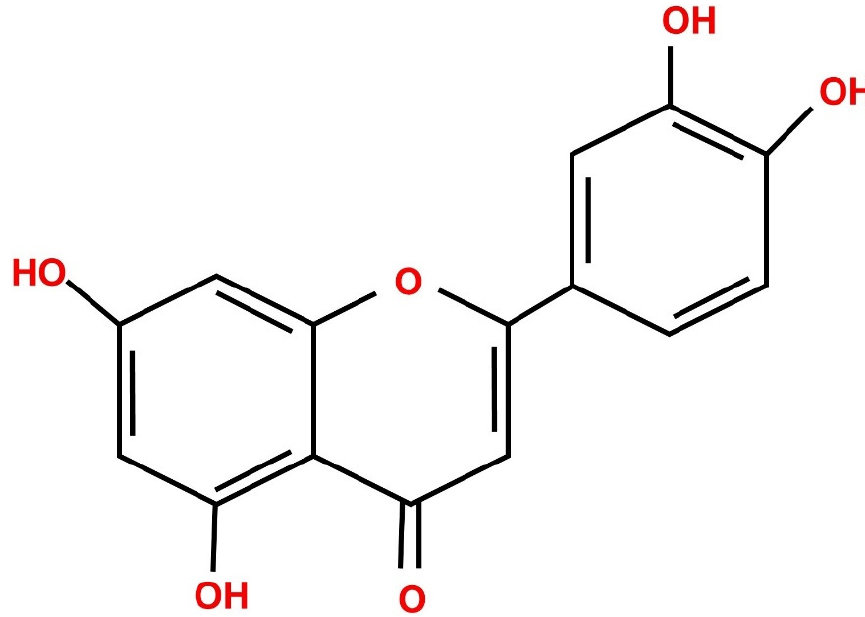
Figure 1. Diagrammatic representation of luteolin compound.